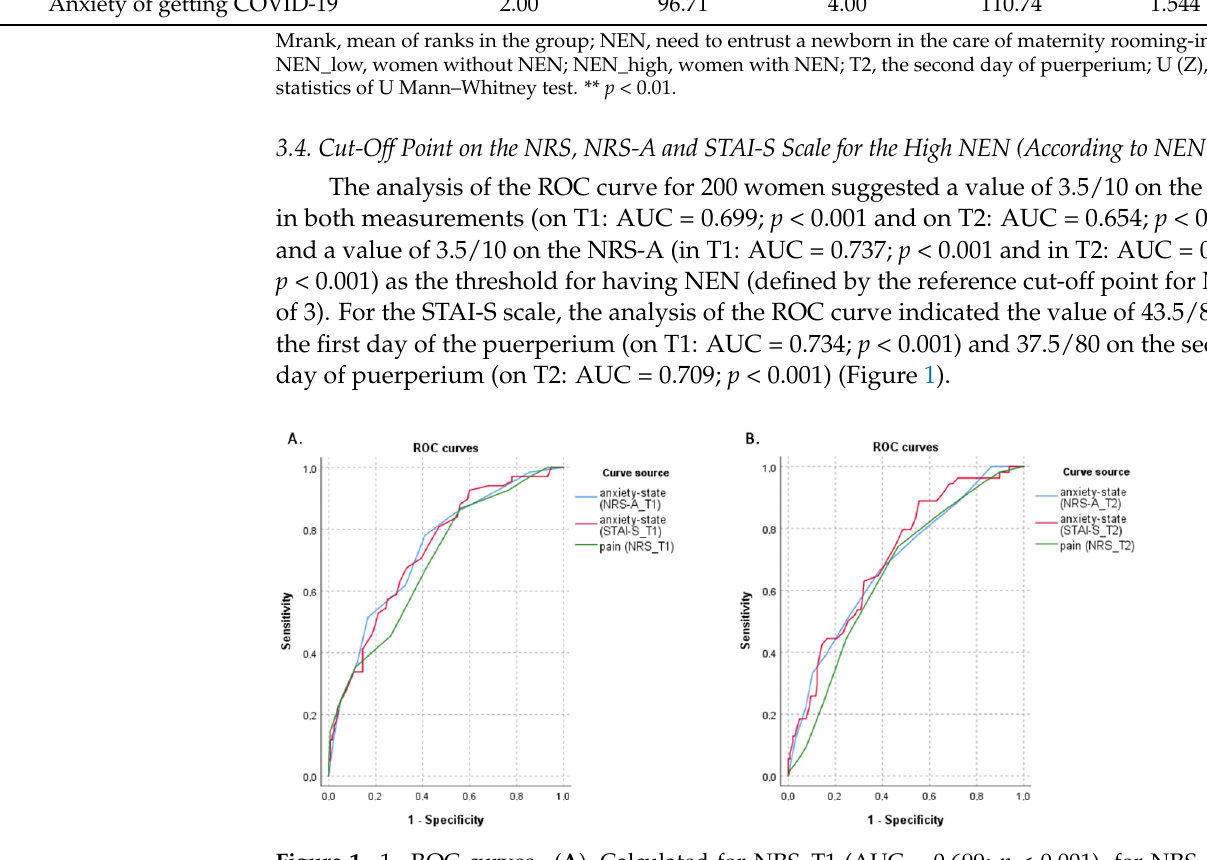
Figure 1. ROC curves. ( A ). Calculated for NRS_T1 (AUC = 0.699; p < 0.001), for NRS-A_T1 (AUC = 0.737; p < 0.001) and for STAI-S_T1 (AUC = 0.709; p < 0.001) using NEN_T1 where a score greater than 3 was selected as an indicator of the presence of NEN on T1. The NRS cut-off value of 3.5/10 reflected the best combination of sensitivity (87%) and specificity (44%). The NRS-A cut-off value of 3.5/10 reflected the best combination of sensitivity (78%) and specificity (59%). The STAI-S cut-off value of 42.5/80 reflected the best combination of sensitivity (68%) and specificity (67%). ( B ). Calculated for NRS_T2 (AUC = 0.654; p < 0.001), for NRS-A_T2 (AUC = 0.689; p < 0.001) and for STAI-S_T2 (AUC = 0.709; p < 0.001) using NEN_T2 where a score greater than 3 was selected as an indicator of the presence of NEN on T2. The NRS cut-off value of 3.5/10 reflected the best combination of sensitivity (74%) and specificity (53%). The NRS-A cut-off value of 3.5/10 reflected the best combination of sensitivity (67%) and specificity (61%). The STAI-S cut-off value of 37.5/80 reflected the best combination of sensitivity (89%) and specificity (44%).